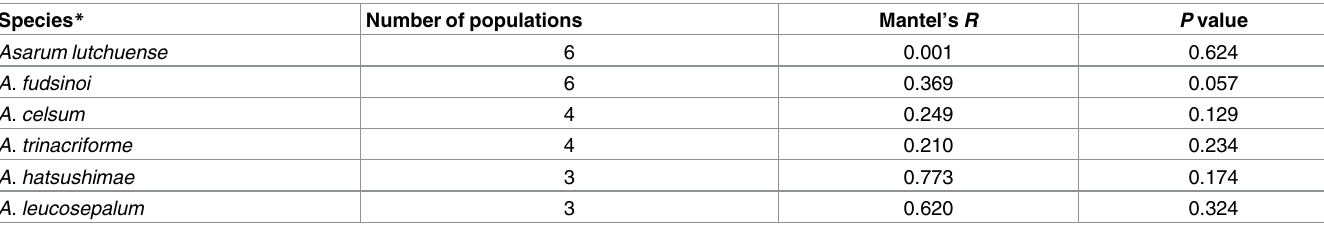
Evidence of a bottleneck The results of tests for mutation–drift equilibrium are presented in S5 Table. Almost all popu- lations showed evidence of a recent bottleneck under both the IAM and the SMM ( P < 0.05; two-tailed sign and Wilcoxon tests). Under the IAM, 14 populations exhibited a significant heterozygosity excess (i.e. evidence of a recent bottleneck) in both the sign and Wilcoxon tests. Under the SMM, significant bottleneck effects were detected in three populations using the sign and Wilcoxon tests. Table 4. Results of Mantel test for the Asarum species on Amami